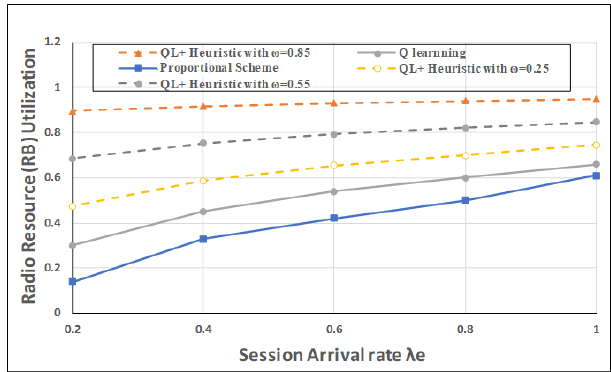
Figure 4. Uplink RB utilization as a function of the eMBB session generation rate λe